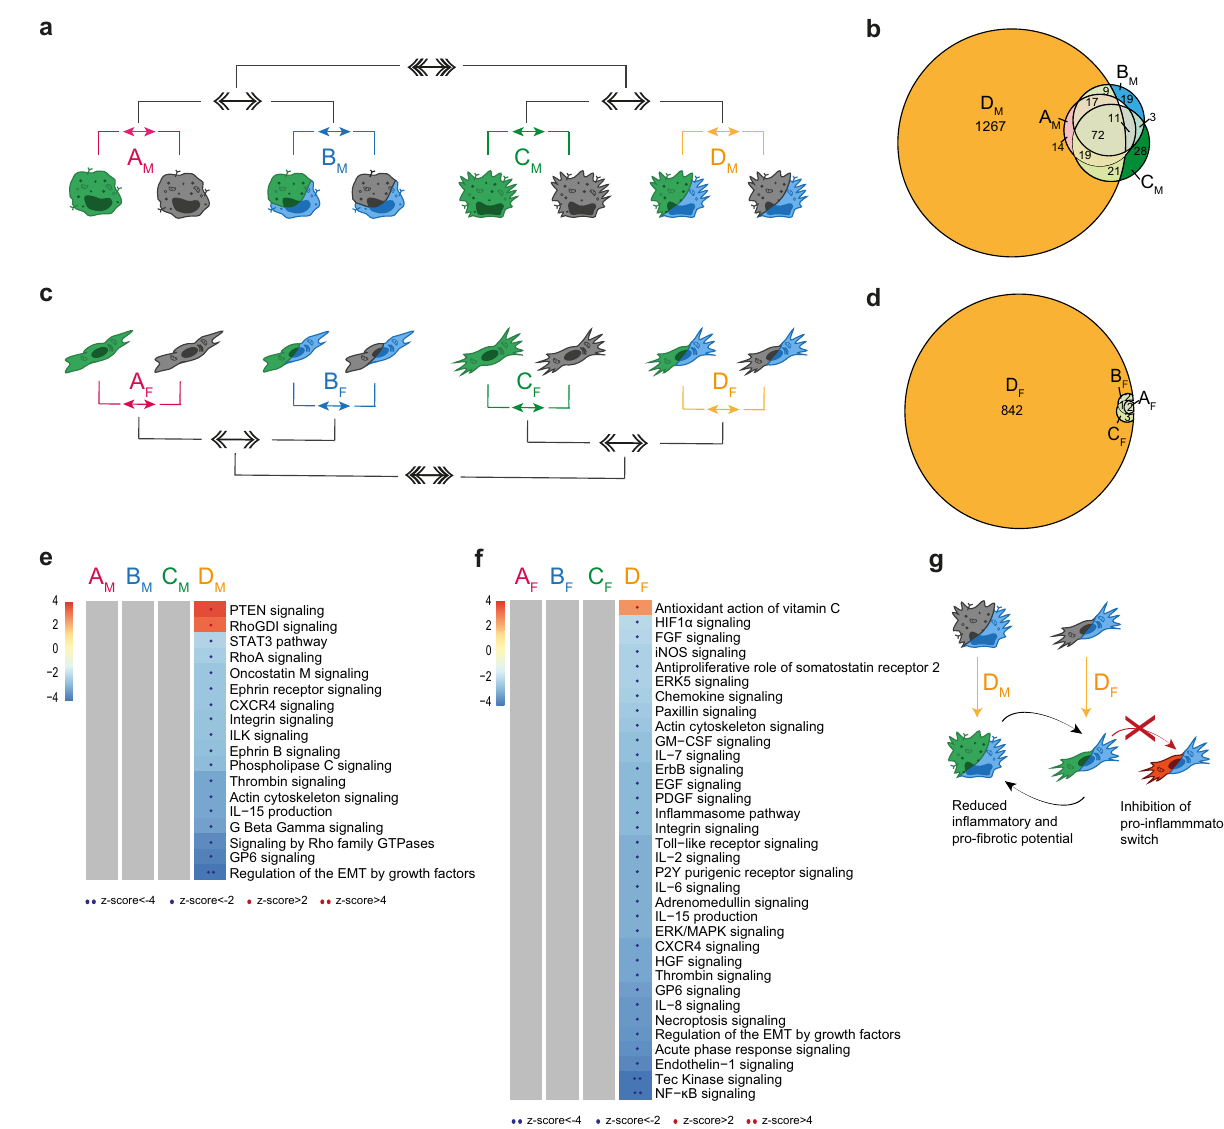
Fig. 3 | Role of adaptive Th2 immune response (IL-4) on the global biological response. a , c Schematic representation of the multi-level approach to study the effect of Th2 cytokine on M φ ( a , b , e ) and Fb ( c , d , f ) in different metabolic and culture conditions. 1st level compares IL-4 stimulated cells to resting cells in four different conditions: normoxic and single culture (comparison A M /A F in pink), hypoxic and single culture (B M /B F in blue), normoxic and coculture (C M /C F in green), hypoxic and coculture (D M /D F in yellow). 2nd level (double arrows) com- pareshypoxictonormoxictreatment(AvsBandCvsD)and3rdlevel(triplearrows) compares coculture to single culture conditions [(A+B)vs(C+D)]. b , d